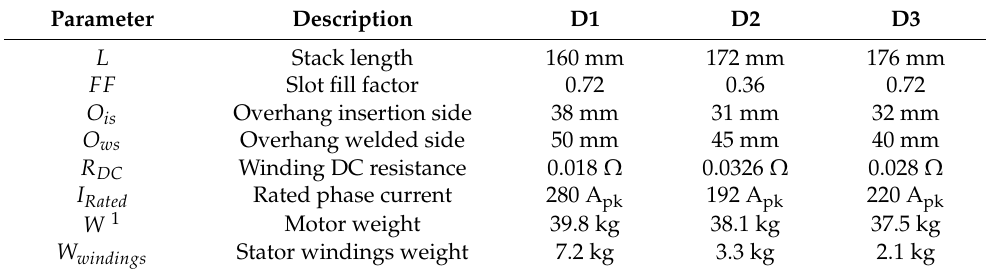
Table 4. Comparison of the IM designs.